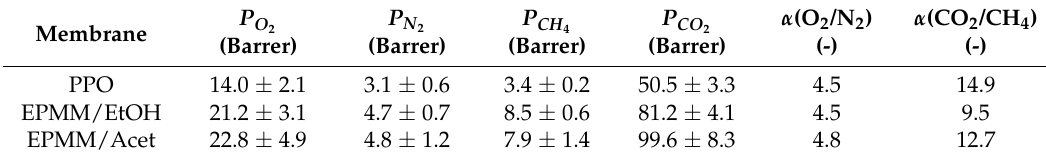
Table 6. Single gas permeabilities and ideal selectivities of the reference PPO and EPMM membranes.